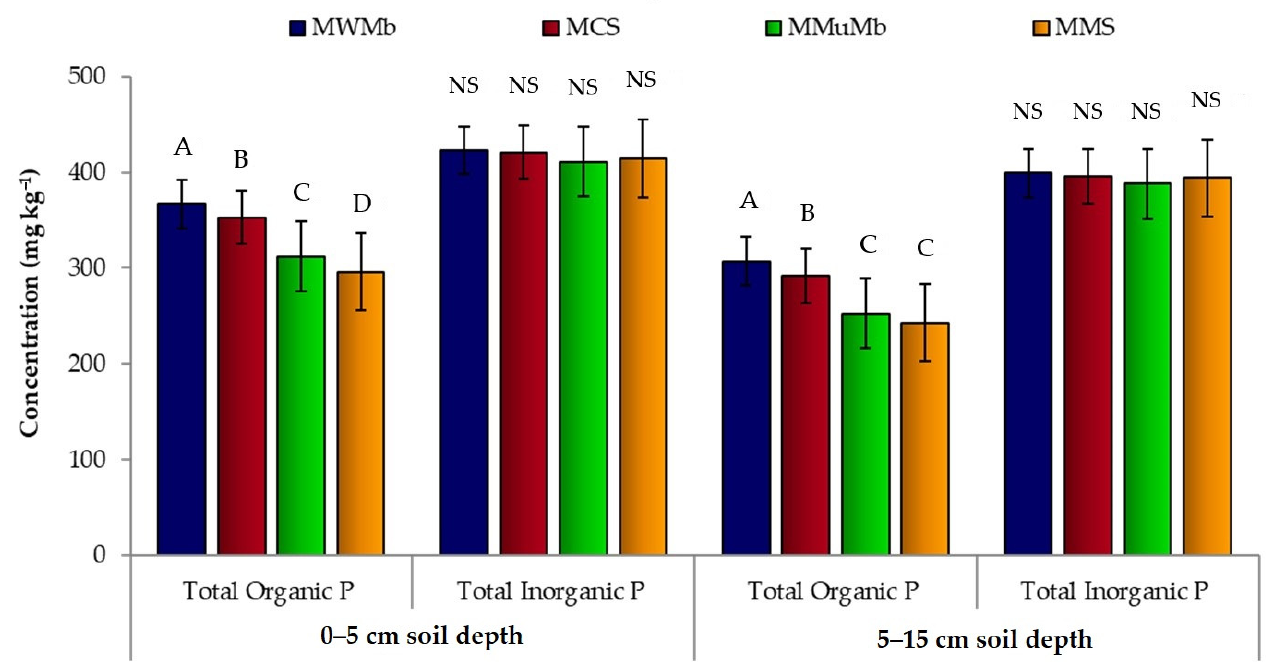
Figure 4. Effect of long-term maize-based crop rotation on total organic and total inorganic P (mg kg –1 ) content at different soil depths. Different letters (A, B, C and D) for each parameter show significant difference at p ≤ 0.05 by Duncan’s Multiple Range Test. NS: Non-significant.